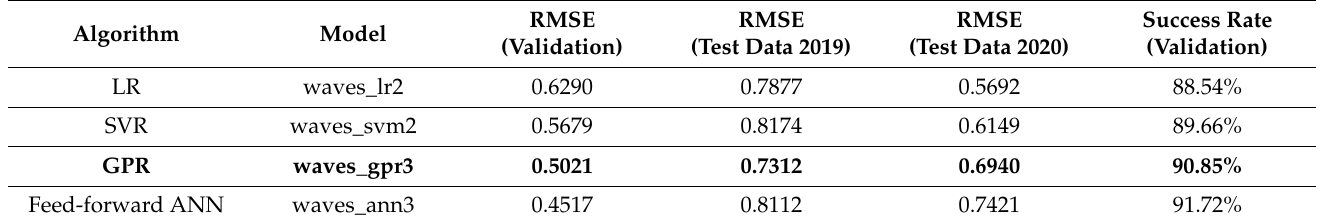
Table 6. Best model results for WVHT prediction for each ML algorithm.